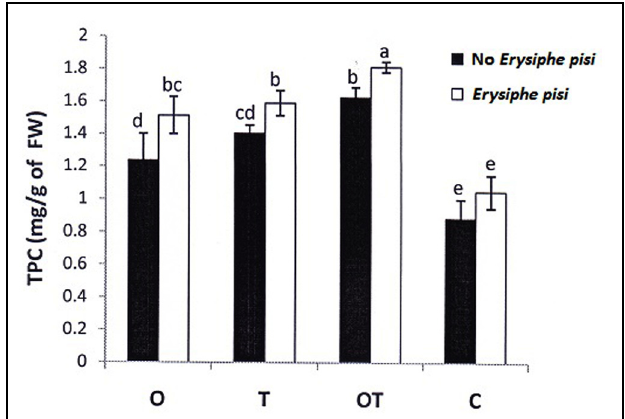
FIGURE 6 | Total phenol content in pea leaves following challenge by E. pisi in different treatments: O- P. fluorescens OKC, T - T. asperellum T42, OT- combination of OKC and T42, C- Control. Error bars represent SD from means of three measurements. Different superscript letters indicate data significantly different from the other treatments ( P ≤ 0.05; Duncan’s multiple range test).